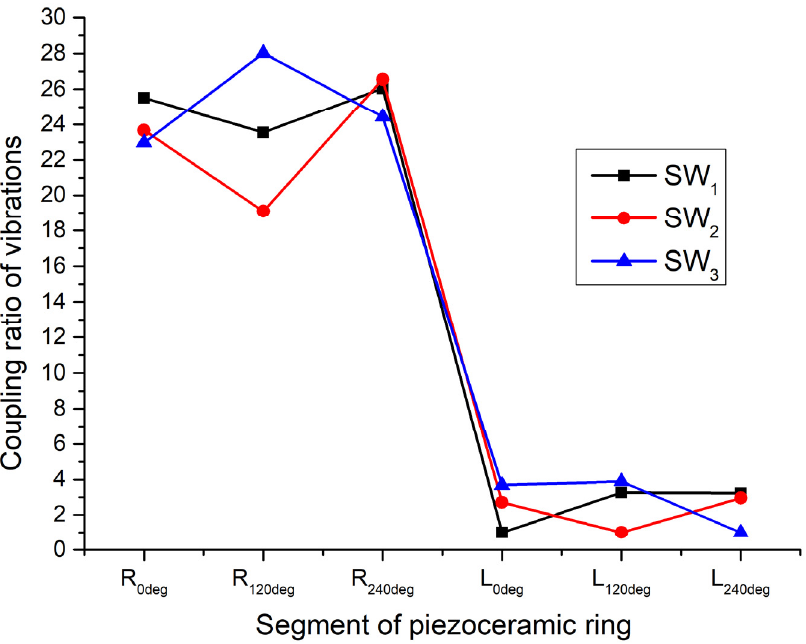
Figure 8. Comparison of vibration coupling ratios when segments L 0deg –L 240deg of the piezo ceramic ring are excited.